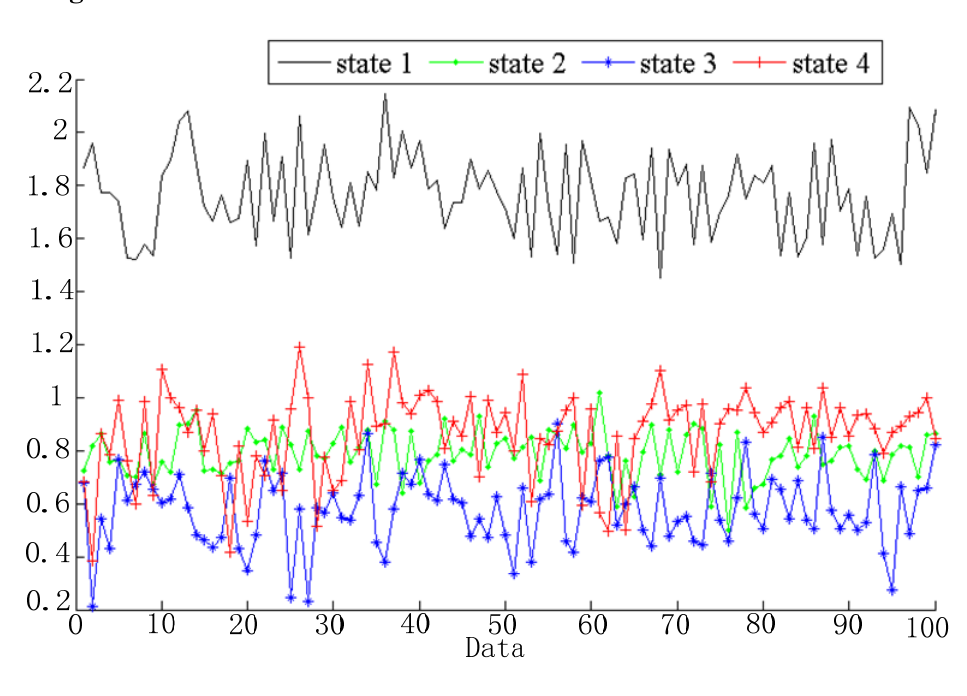
Figure 6. The first dimension of the feature vectors for each health